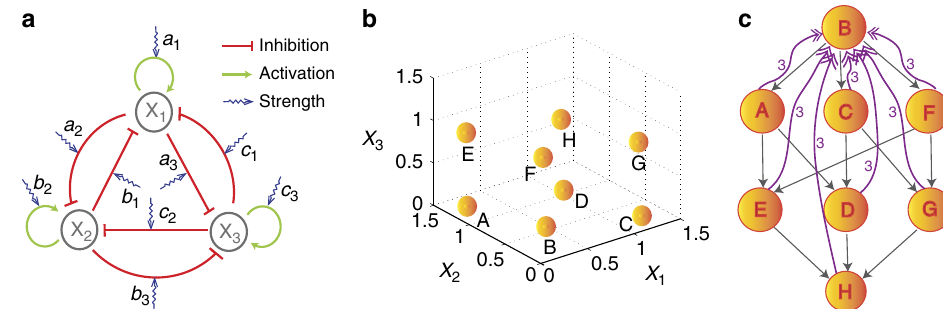
Figure 7 | A GRN of three nodes and its attractor network. ( a ) Schematic illustration of a three-node GRN system. The arrowhead and bar-head edges represent activation and inhibitory regulations, respectively. The sawtooth lines specify that the corresponding edge strength is experimentally adjustable. ( b ) Coexisting attractors ( A to H ) in the phase space. ( c ) The underlying attractor network, where each node represents an attractor and each weighted directed link indicates that its strength can be experimentally tuned to steer the system from the starting attractor to the pointed attractor. Each grey directed link with a single arrow indicates that only one parameter is needed to achieve control, and each purple link with a double-arrow and the label 3 represent the case where three parameters are required to achieve